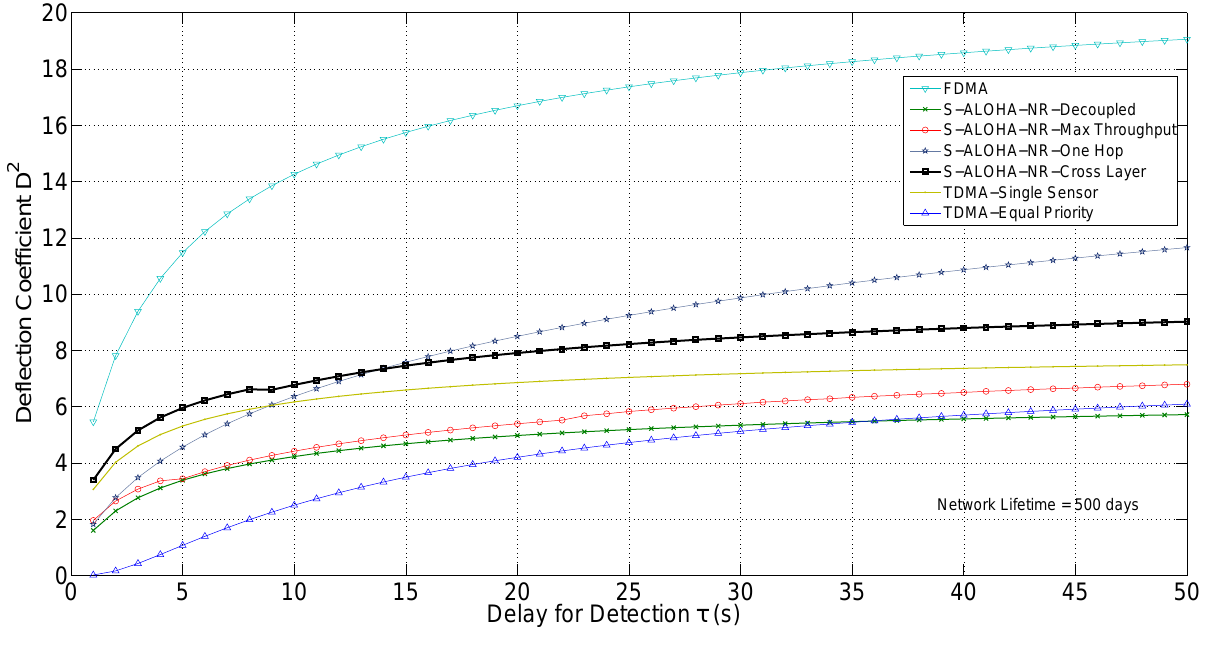
Figure 13. Deflection coefficient for various network